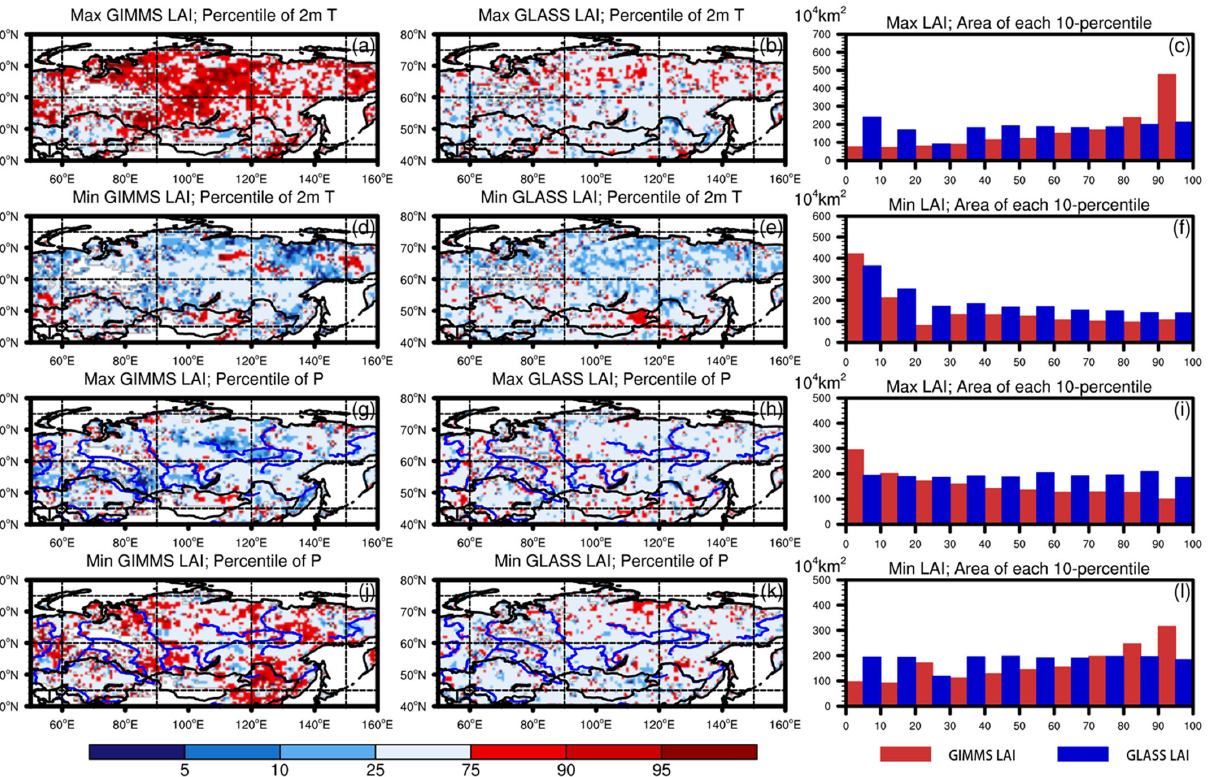
Figure 4. Percentiles of the 2 m air temperature ( a , b , d , e ) and precipitation ( g , h , j , k ) when the maxi- mum ( a , b , g , h ) and minimum ( d , e , j , k ) GIMMS LAI ( a , b , g , h ) and GLASS LAI ( d , e , j , k ) were recorded. The histograms in ( c , f , i , l ) show the corresponding percentile distributions of the accumulated area (unit in 10 4 km 2 ).